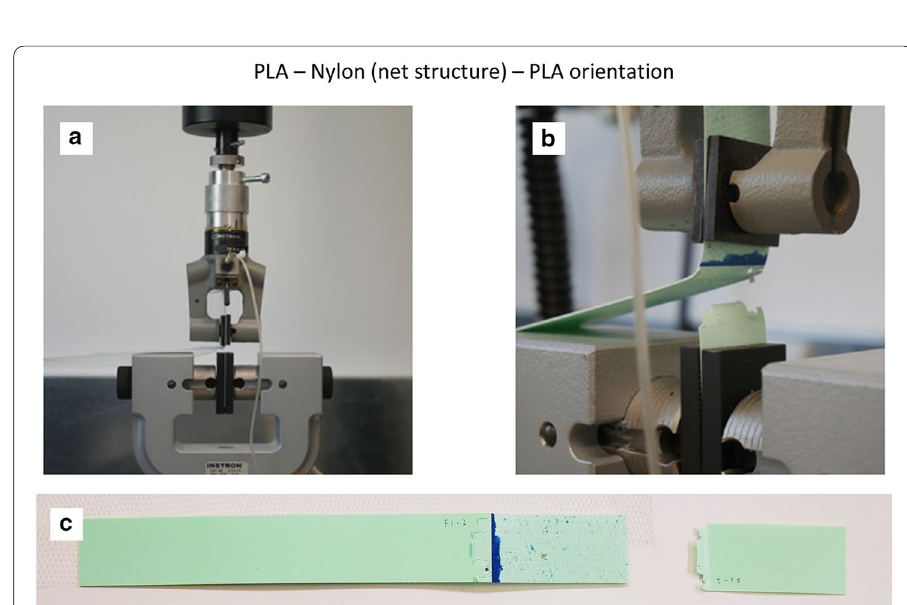
Fig. 4 a Test setup, b failure mode for the PLA—Nylon (net structure)—PLA orientation and c failure of an adherend (cohesive substrate